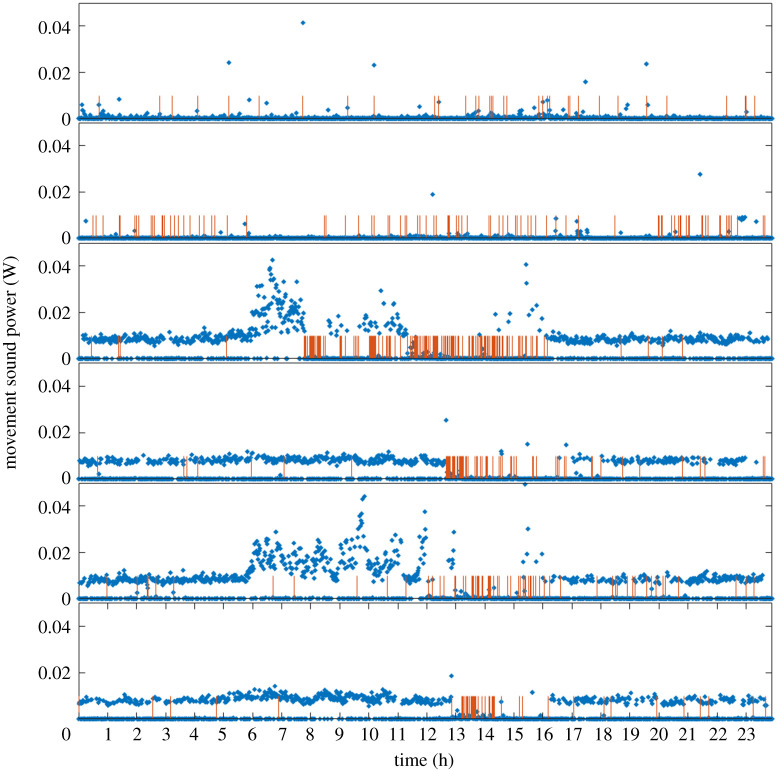
Sound power produced by the movement of 100 H. halys males contained in a wooden shelter over a 24 h time span over six weeks during the pre-diapause season (October–mid-November), where week 1 is the top panel and week 6 is the bottom panel. Spikes represent the time of day where calling vibrations were detected and tended to reach peak levels during periods in which insects were least active.